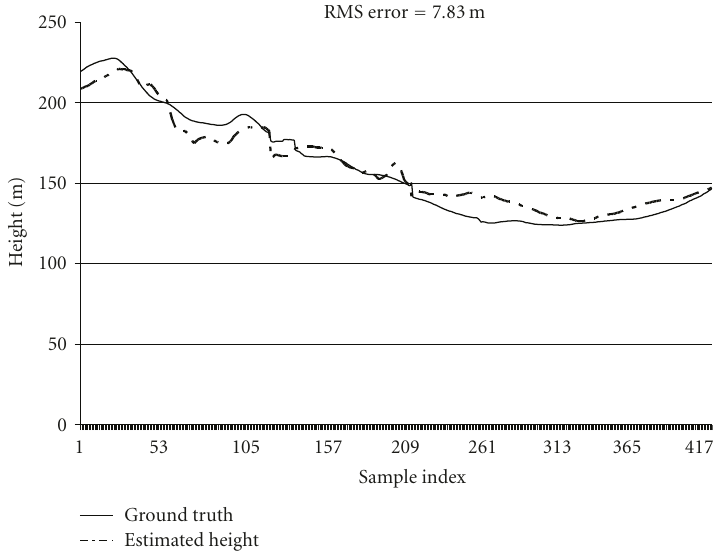
Figure 5: Height estimate from selective weighting technique (Route 2).